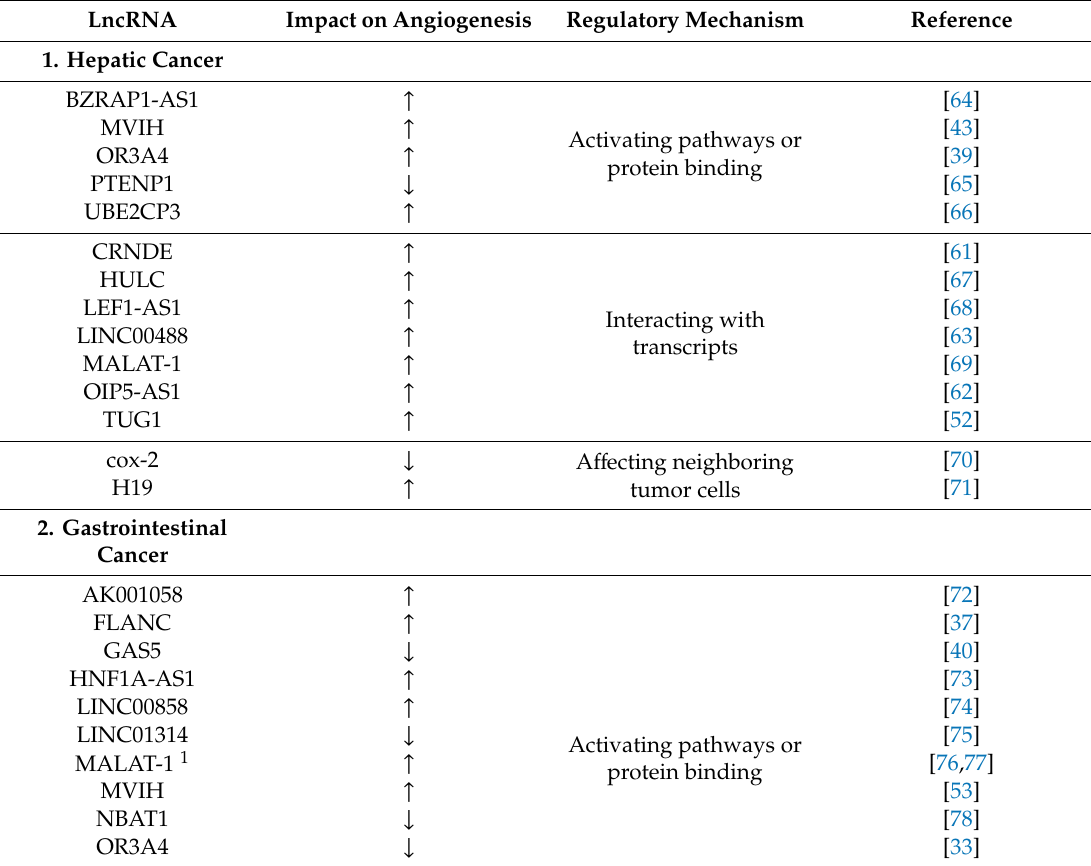
Table 1. Overview of long non-coding RNAs (lncRNAs) influencing tumor angiogenesis through di ff erent regulatory mechanisms in various cancer